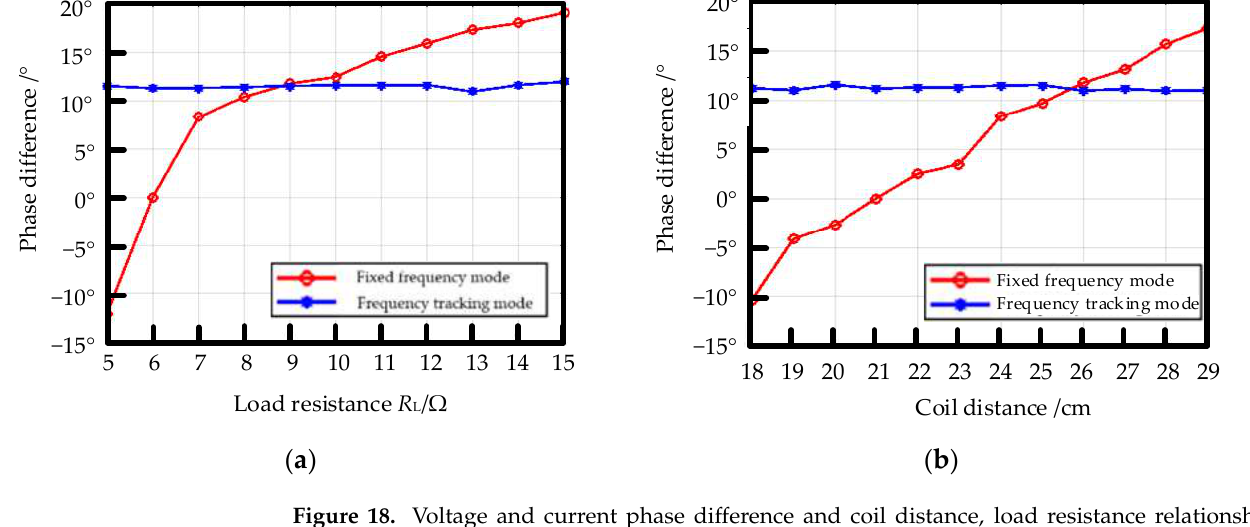
Figure 18. Voltage and current phase difference and coil distance, load resistance relationship diagram: ( a ) voltage and current phase difference versus load diagram; ( b ) voltage and current phase difference versus coil distance diagram.